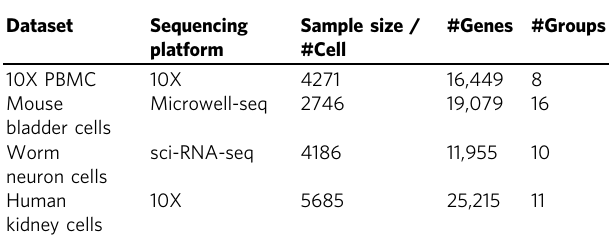
Table 1 Summary of four small scRNA-seq